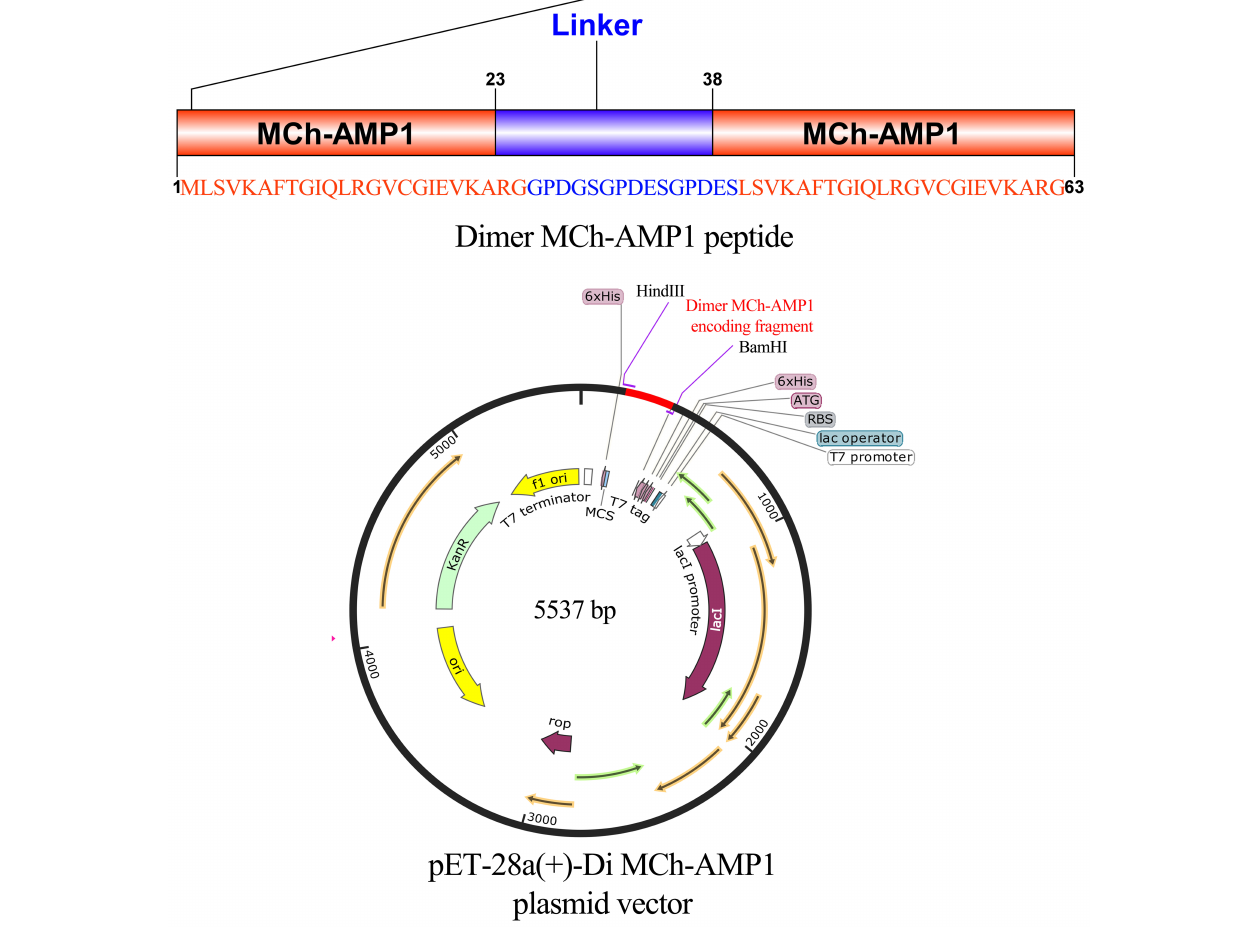
FIGURE 3 | Gene construction of the plasmid carrying pET28a( + )-DiMCh-AMP1. The organization of the gene and amino acid sequences in pET28a( + )-DiMCh-AMP1. Schematic representation of the expression